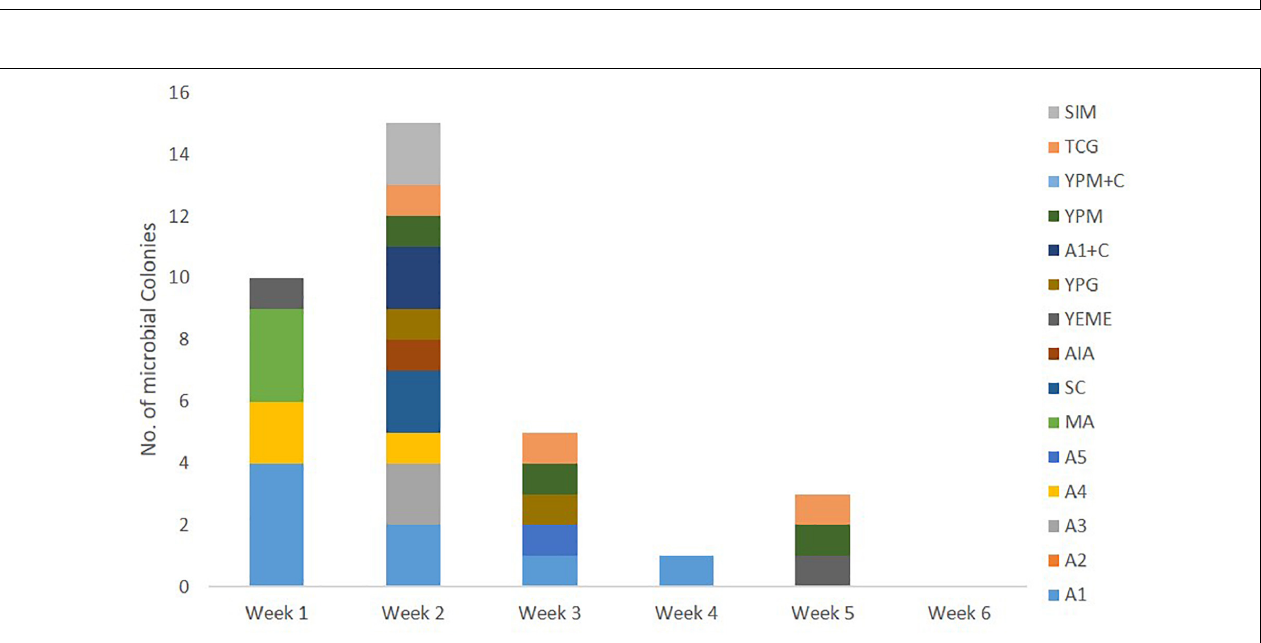
FIGURE 3 | Number of marine bacterial colonies isolated from samples of Cliona patera , NP1 and NP6, over a 6-week incubation period in various marine media.